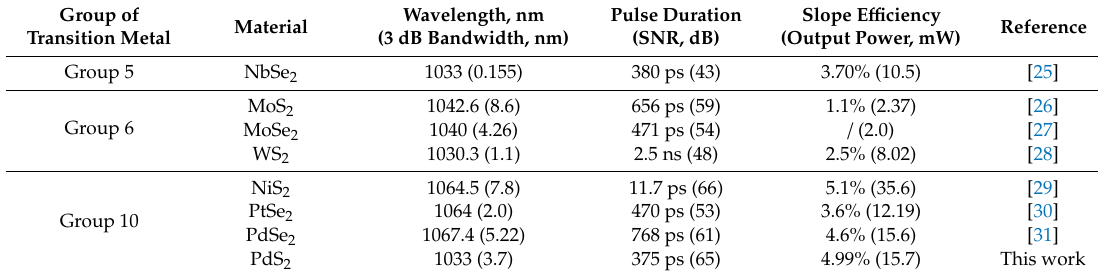
Table 1. Various TMD-based SAs for mode-locking operation in Ytterbium-doped fiber laser